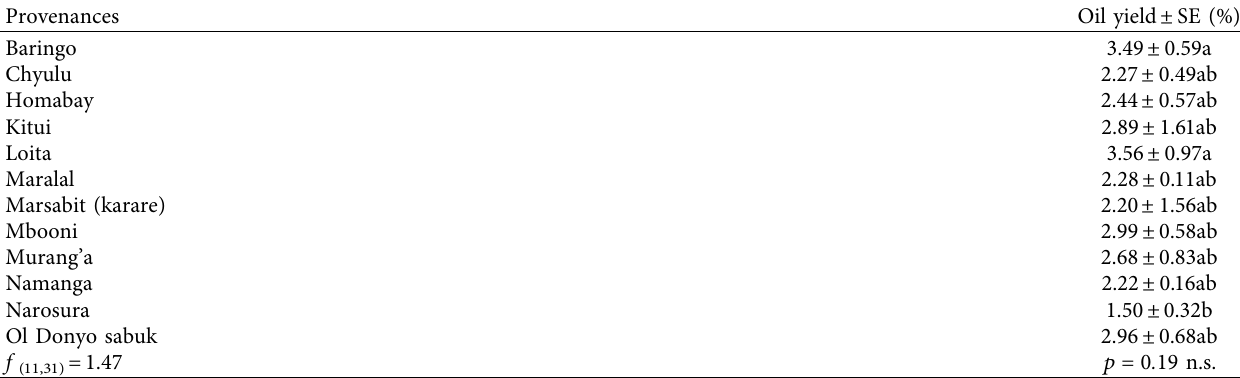
Table 4: Oil yield potential in diferent provenances in Kenya.